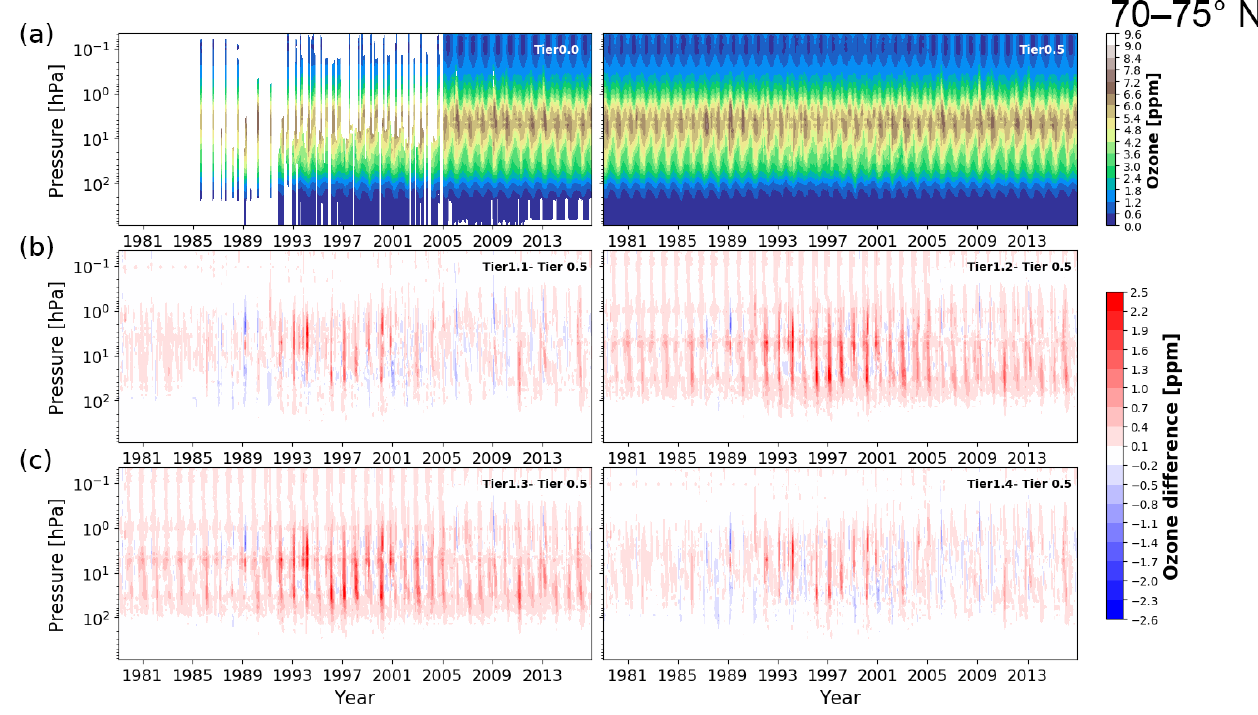
Figure 7. Same as Fig. 6 but for the latitude band 70 to 75 ◦